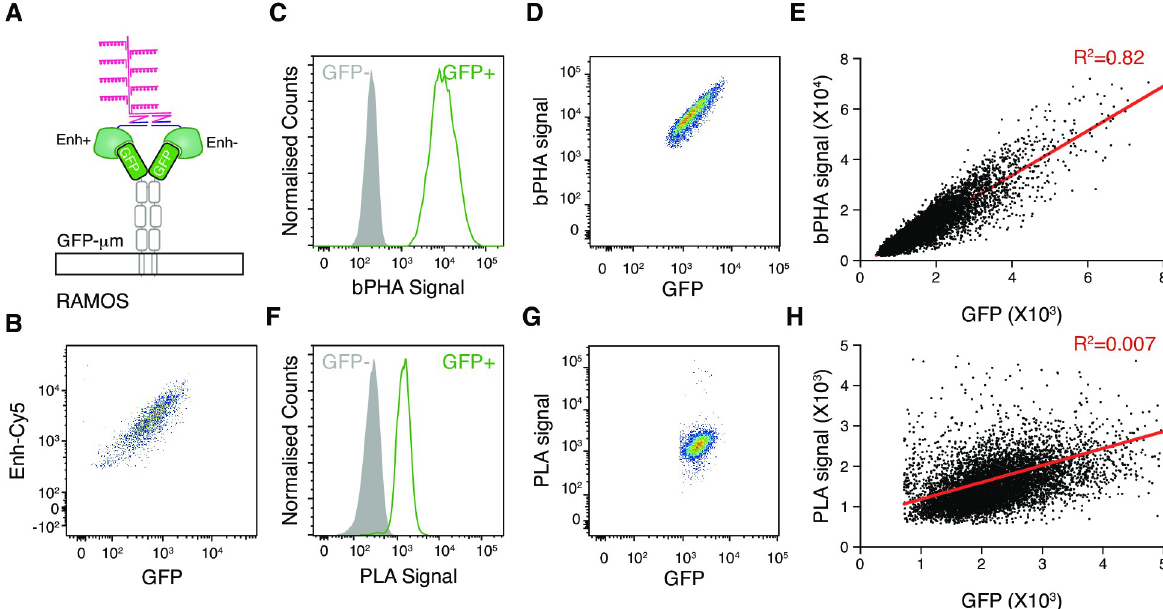
Fig 2. The bPHA provides an excellent quantitative measurement of protein proximity in a large dynamic range. (A) Schematic illustration showing that every GFP- μ m expressed on Ramos cells surface have two GFPs in proximity that could be detected by Enh+:Enh − bPHA. (B) Flow cytometry results showing that the surface GFP- μ m expression as assayed by Enh Cy5 staining is correlated with the GFP expression level. Gated for GFP+ cells. (C) Enh+:Enh − bPHA signal measured by flow cytometry for GFP − and GFP+ cells. (D) Flow cytometry results showing that the Enh+:Enh − bPHA signal is correlated with GFP signal. Gated for GFP+ cells. (E) Statistical analysis for data presented in (D). Raw data used for this plot are included in S1 Data. (F) Enh:Enh PLA signal measured by flow cytometry for GFP − and GFP+ cells. (G) Flow cytometry results showing that the Enh:Enh PLA signal is not correlated with GFP signal. Gated for GFP+ cells. (H) Statistical analysis for data presented in (G). Raw data used for this plot are included in S2 Data. Data are representative of a minimum of three independent experiments. bPHA, branched proximity hybridization assay; Cy5, cyanine 5; Enh, Enhancer; GFP, green fluorescent protein; PLA, proximity ligation assay.